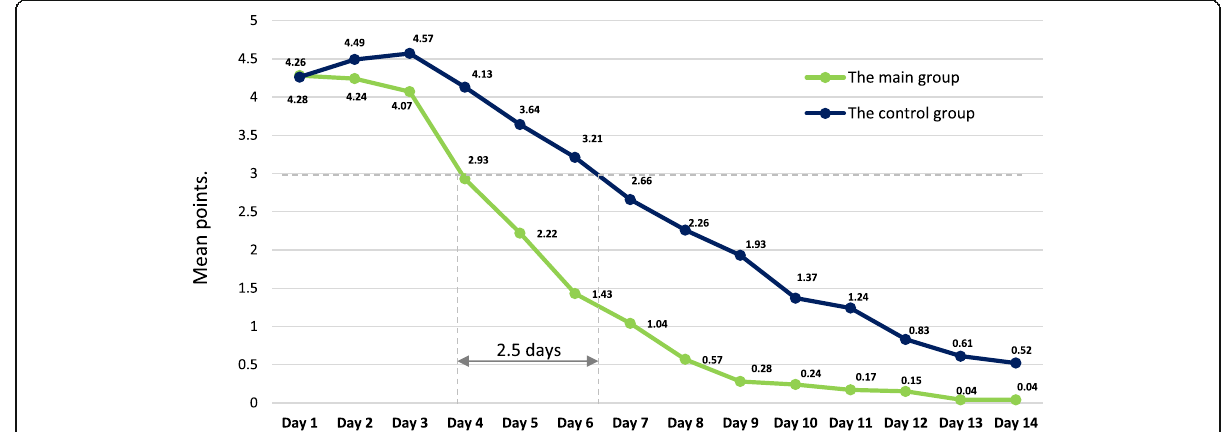
Fig. 3 Fever severity dynamics in the groups according to the self-assessment results